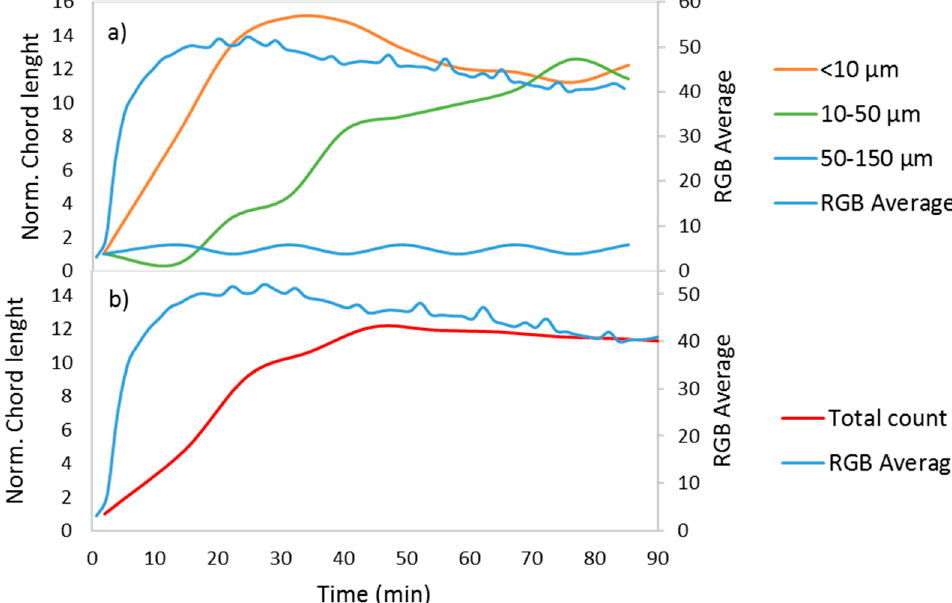
Figure 4. Normalized chord length and RGB average for a calcium carbonate precipitation process with 70% m / m of MEG for ( a ) particles sized <10 µm and 10–50 µm and ( b ) the total count.